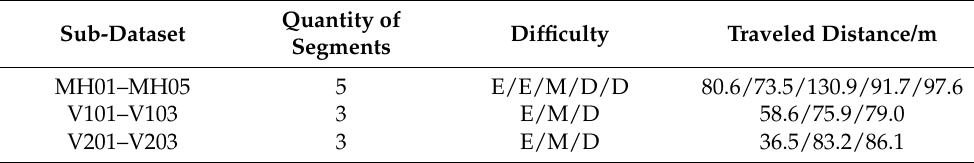
Table 1. Sub-datasets of the EuRoc